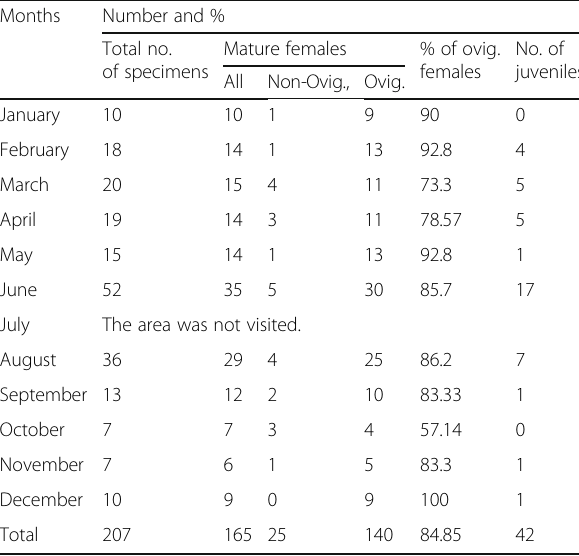
Table 2 Total number of collected specimens and percentages of ovigerous females and number of juveniles of H. marsupialis from Gulf of Aqaba, Red Sea, Egypt